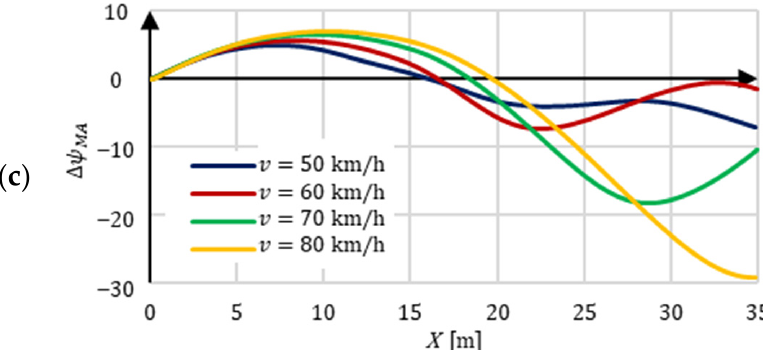
Figure 5. Planned driving path and resultant trajectory of the car for several driving velocities; v = 50, 60, 70, 80 km/h; ( a ) planned driving path y M ( x ) and trajectory y CA ( x ) ; ( b ) lateral deviation ∆ y MA of the trajectory (movement of the center of mass) from the planned driving path; ( c ) longitudinal axis of the car’s angular deviation ∆ ψ MA from the tangent to the planned driving path. The figures show the influence of driving velocities on driving trajectory deviations from the planned path. The lateral forces (centrifugal forces) increase with increases in driving velocity on the curvilinear path, which causes sideslip and lateral skidding of the tires. As a result, an increase in the lateral deviation ∆ y MA of the driving trajectory from the planned path is observed and increased angular deviation of the longitudinal vehicle axis ∆ ψ MA . This issue is one of the most important problems in experimental AV